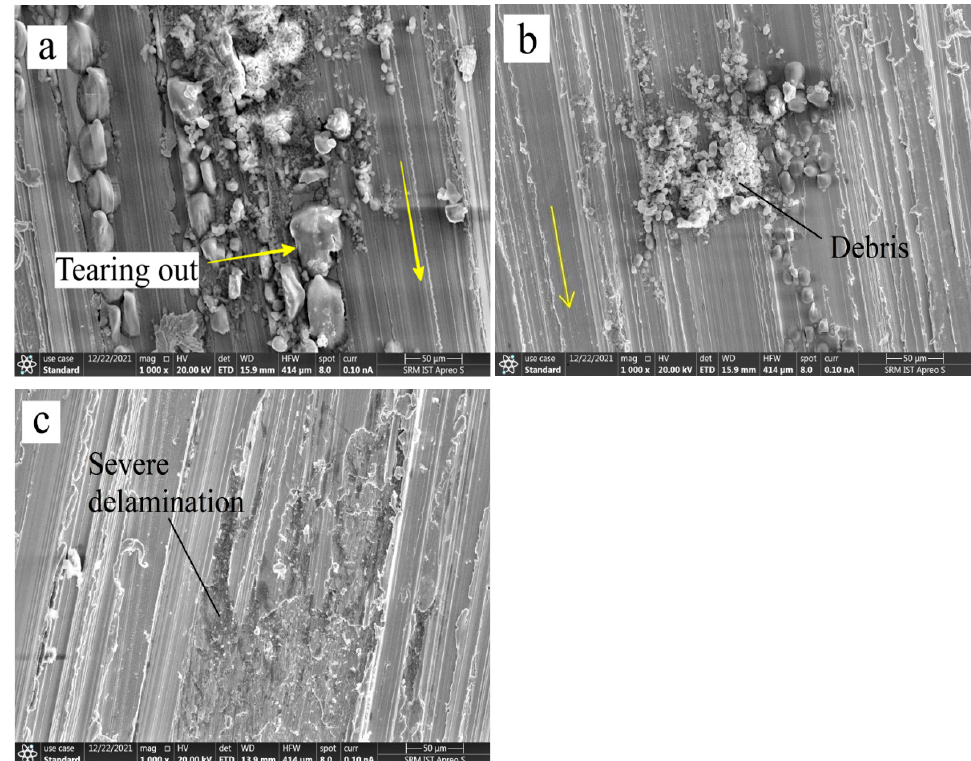
Figure 5. Wear morphology of EN 52 steel without DCT showing ( a ) tearing out ( b ) debris ( c ) severe wear and deformation.